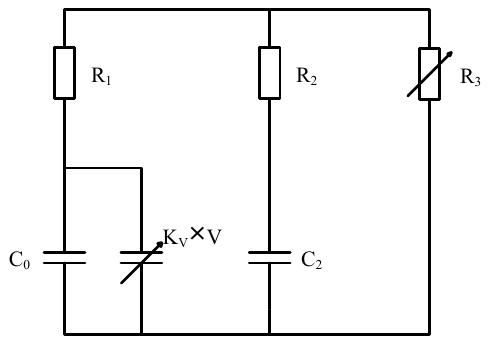
Figure 11. Self-discharge models.